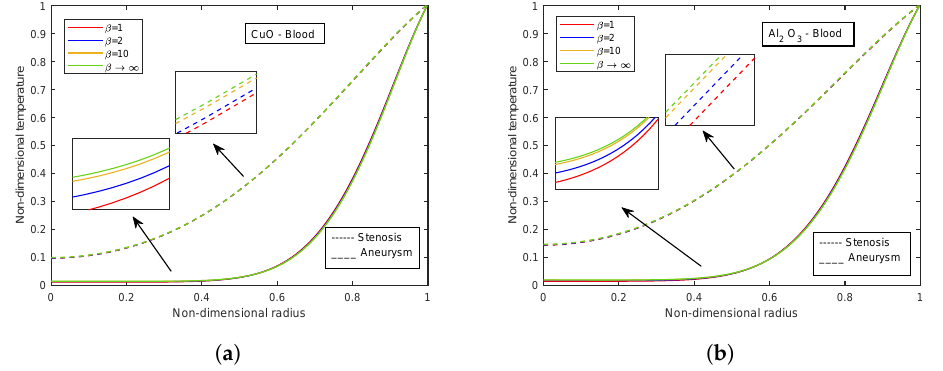
Figure 25. Temperature profiles of Casson fluid parameter β for ( a ) CuO-nanoparticles, ( b ) Al 2 O 3 -nanoparticles.